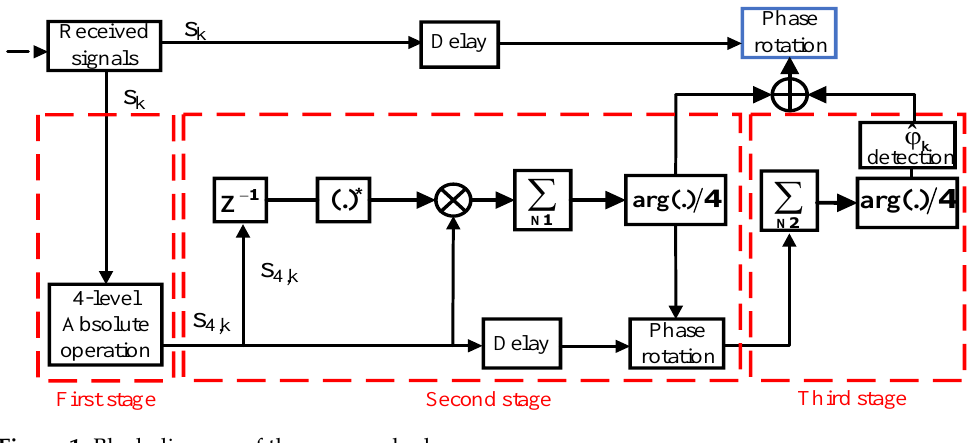
Figure 1. Block diagram of the proposed scheme.